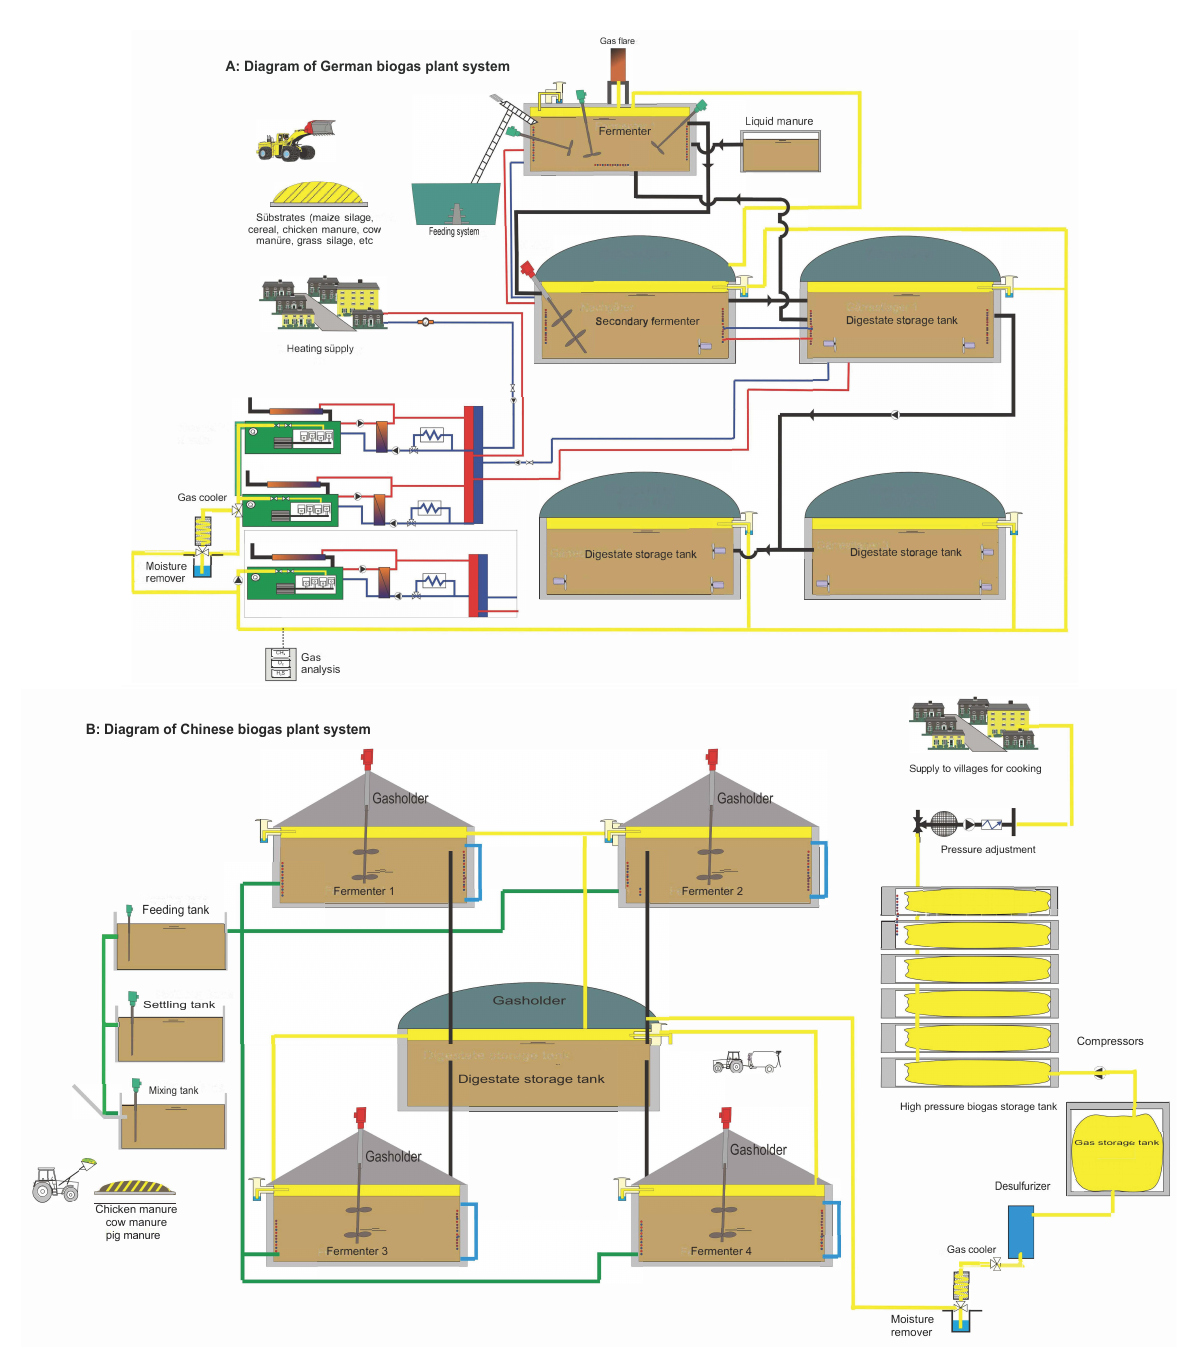
Figure 1. Diagram of the generally selected German ( A ) and Chinese ( B ) biogas plants.